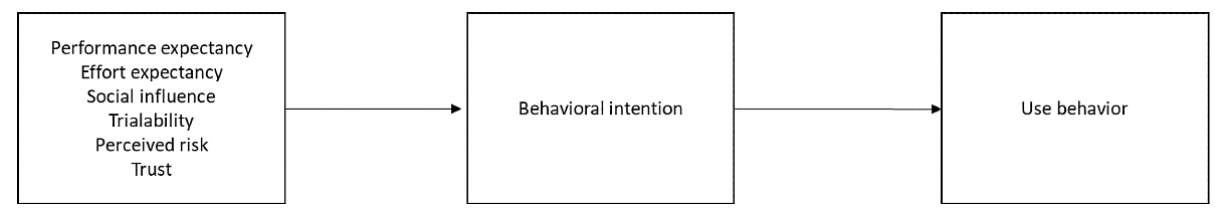
Figure 1. Conceptual